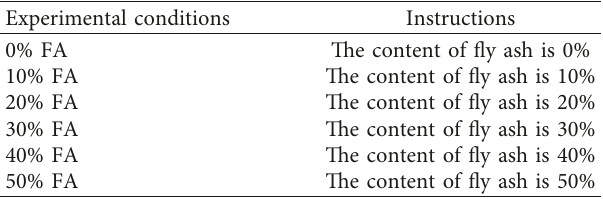
Table 1: Design of experimental conditions and instructions.